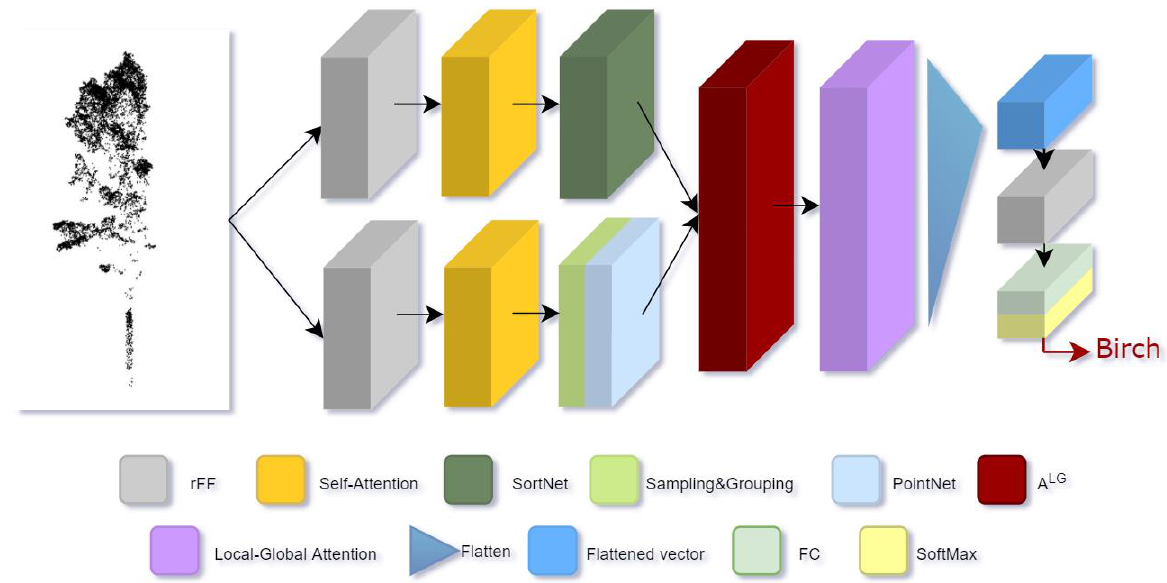
Figure 9. The architecture proposed (PT2) by Engel [30]. rFF represents row-wise feed-forward network, SortNet is a local feature generation module, 𝐴 𝐿𝐺 generate local-global attention by relating global features with local features, and FC represents fully connected layer.